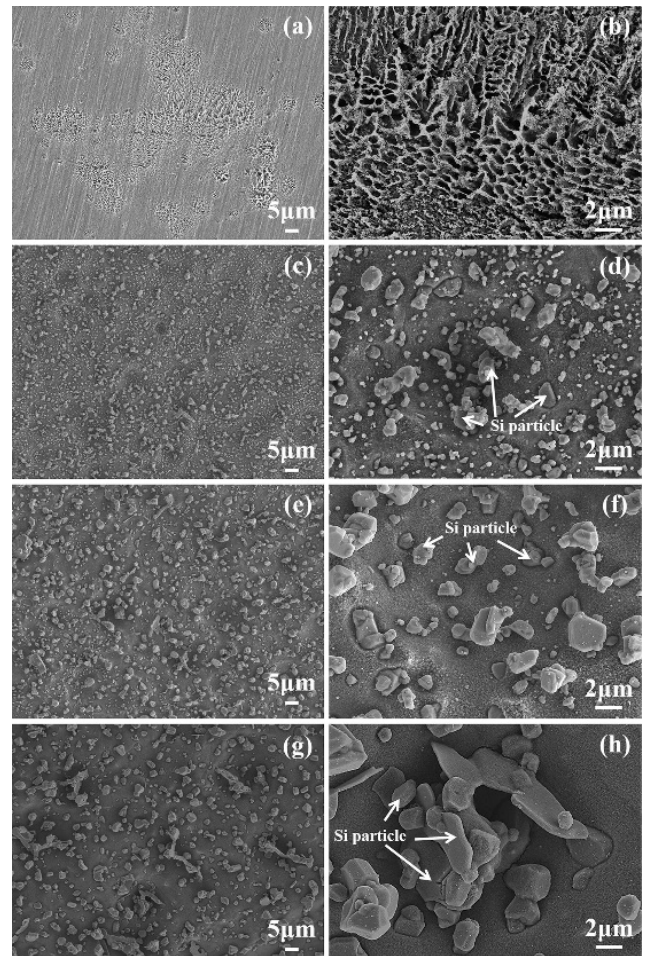
Figure 11. SEM micrographs of SLM produced AlSi10Mg alloys after 45 days immersion in 3.5 wt. % NaCl solution: ( a , b ) untreated; ( c , d ) post heat treatment at 450 °C; ( e , f ) post heat treatment at 500 °C; ( g , h ) post heat treatment at 550 °C [67].